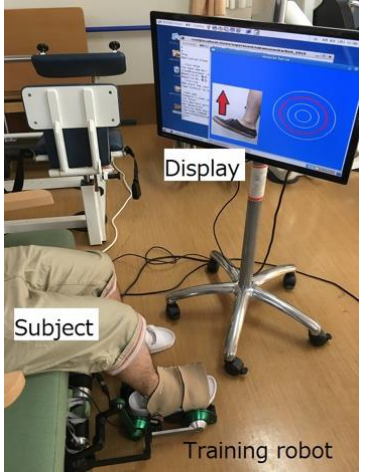
Figure 4. Actual training scene.